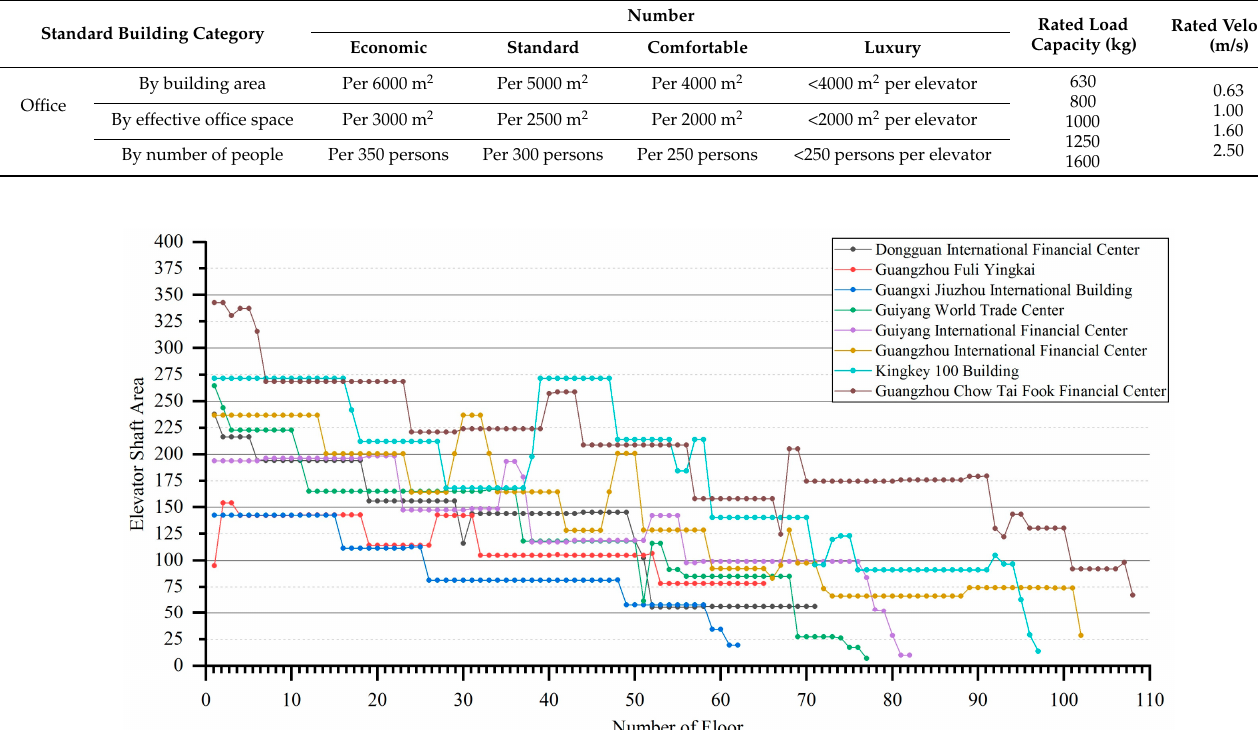
Figure 15. Elevator shaft area of the typical floor.